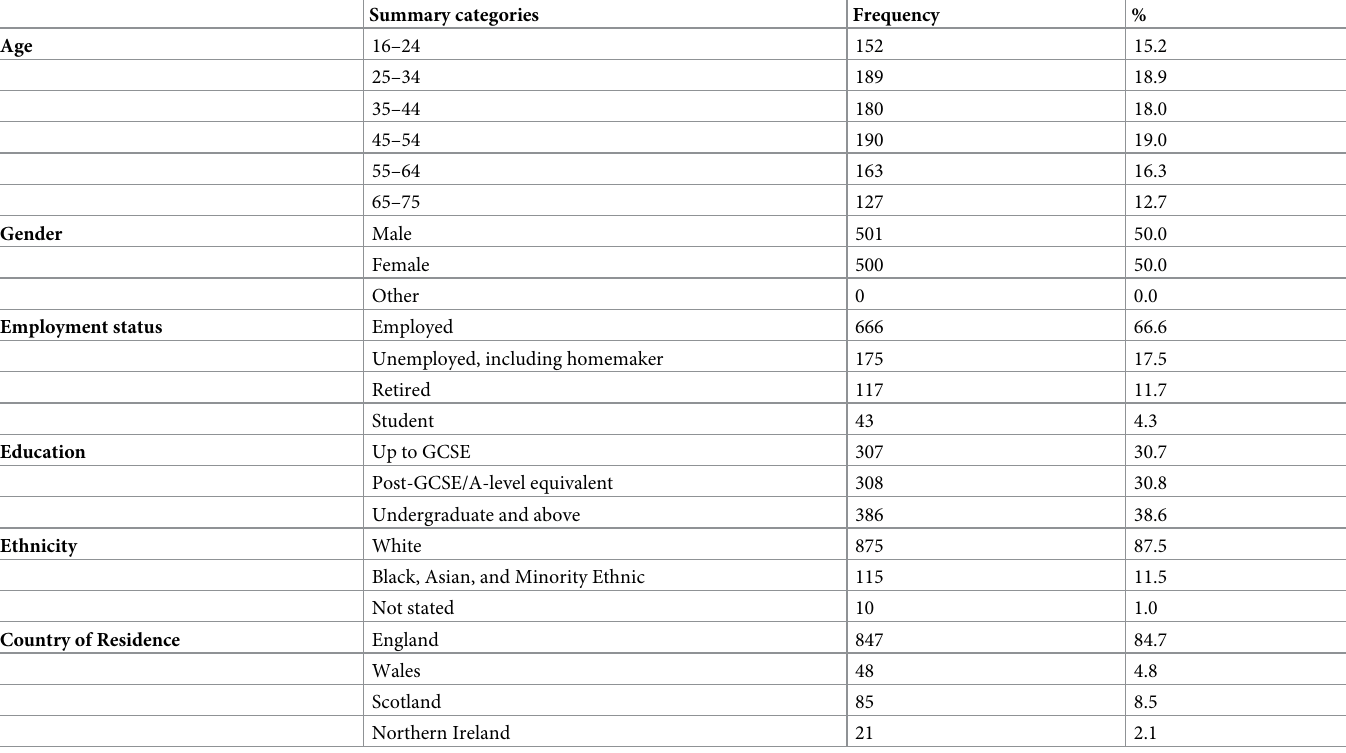
Table 1. Summary characteristics of participants in the online questionnaire, n =